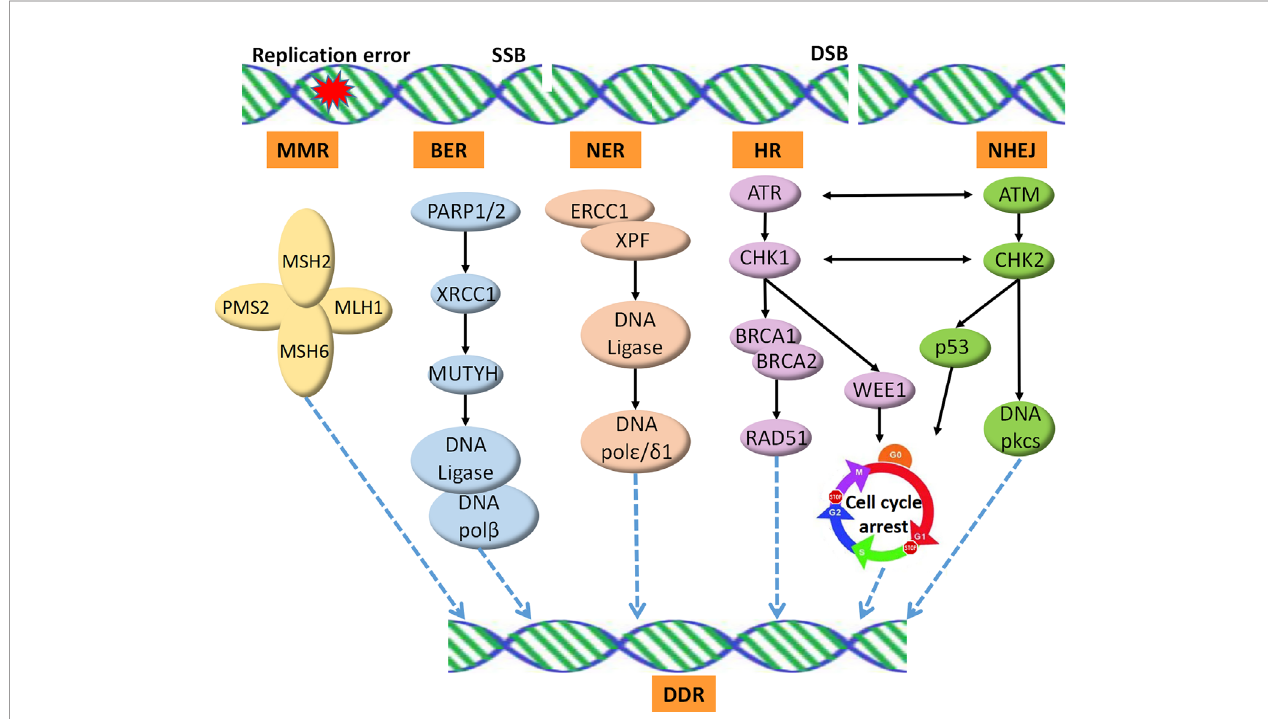
FIGURE 1 | DNA damage repair pathways. SSB is repaired by the BER, NER, or MMR machineries. DSB is repaired by HRR, an accurate DNA repair pathway, or NHEJ, which is an error-prone pathway. SSB, single strand break; DSB, double strands break; MMR, mismatch repair; NER, nucleotide excision repair; BER, base excision repair; HR, homologous recombination repair; NHEJ, non-homologous end joining; DDR, DNA Damage